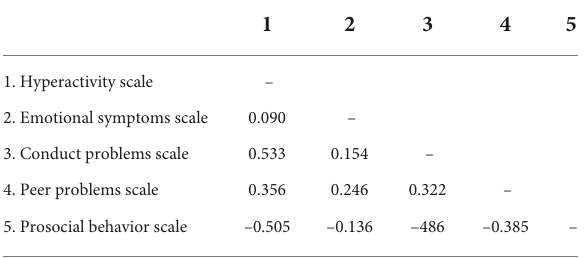
against a and c against b): (a) equivalence of the structure (configural invariance), (b) equivalence of factor loadings (weak invariance), and (c) equivalence of item intercepts (strong